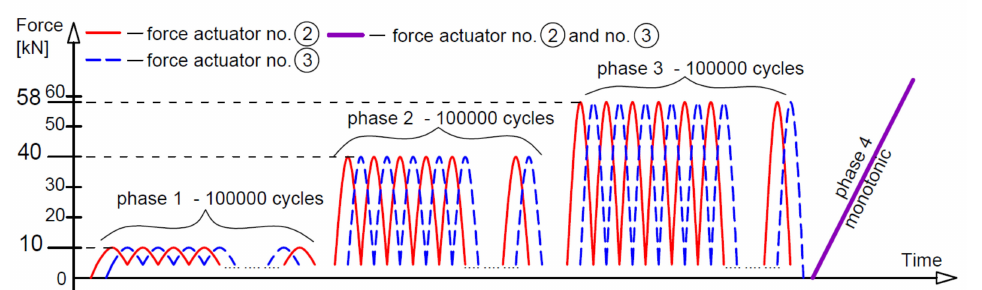
Figure 8. Low-cycle